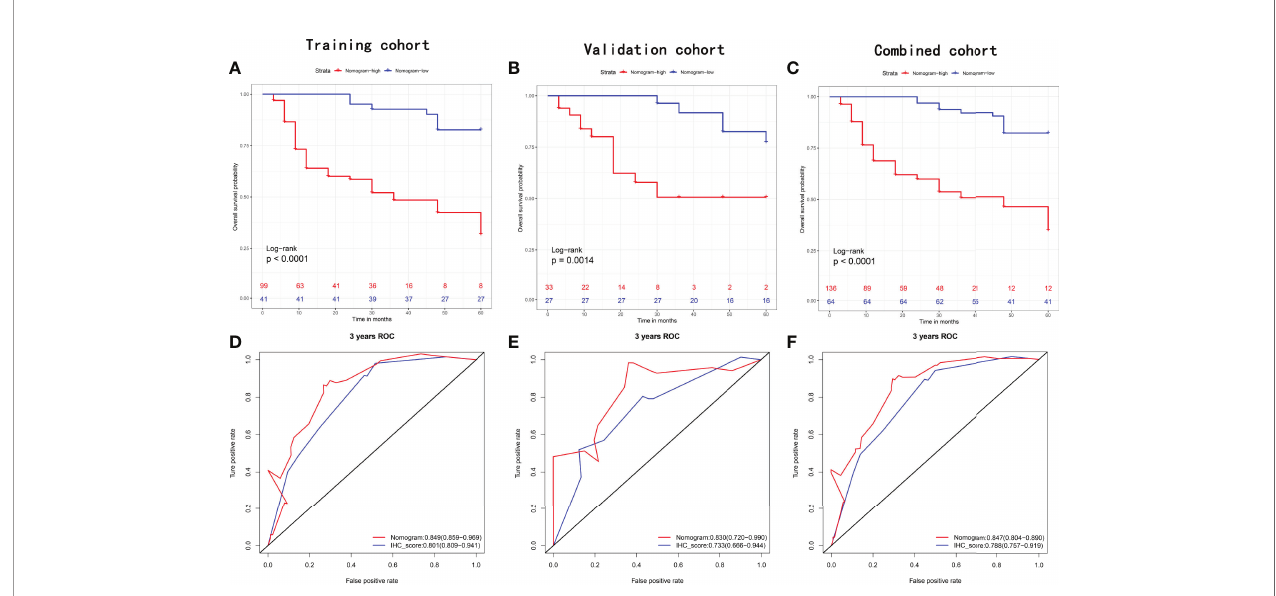
FIGURE 6 | Recurrence-free survival analysis with Kaplan-Meier method for patients divided by nomogram in the (A) training set, (B) validation set, and (C) combined set. ROC with AUC of recurrence-free survival at 3-year predicted by nomogram and IHCscore in the (D) training set, (E) validation set, and (F) combined